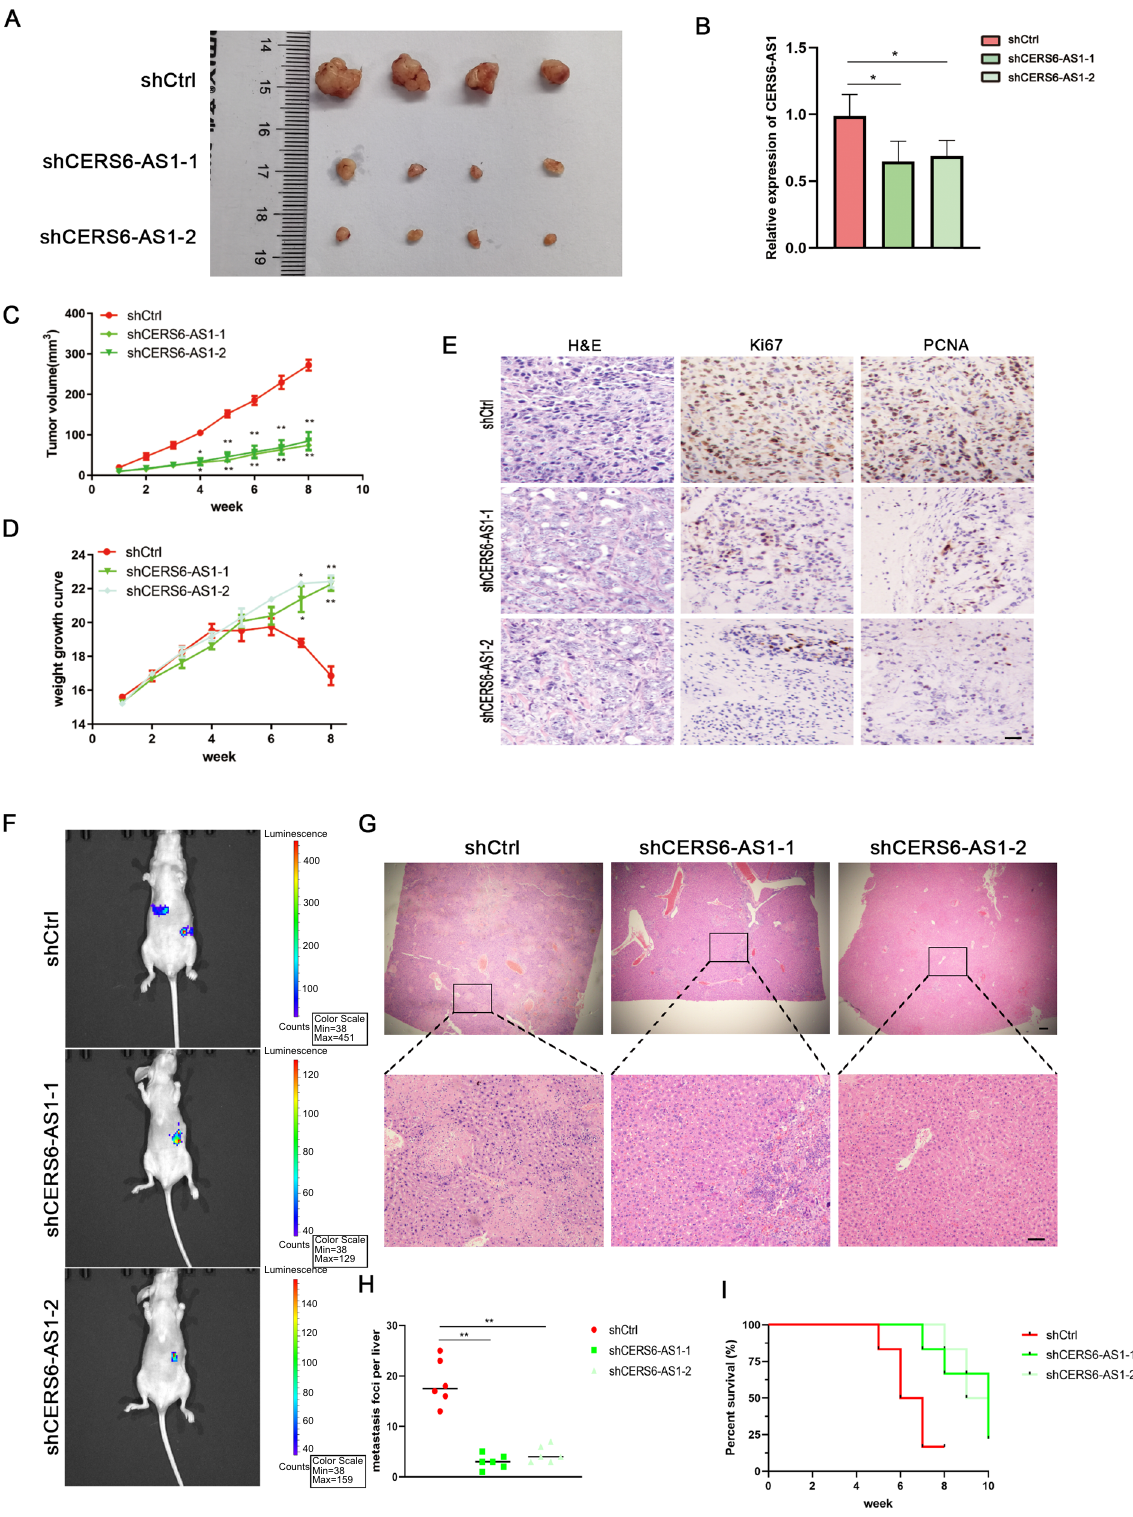
Fig. 3 CERS6-AS1 downregulation inhibits PC proliferation and invasion in vivo. A Tumor photographs of the subcutaneous xenografts in shCtrl and shCERS6-AS1 groups, n = 4, cell line: PANC-1. B The relative RNA expression of CERS6-AS1 in subcutaneous tumors was detected by PCR. C Tumor volume of the subcutaneous xenografts in shCtrl and shCERS6-AS1. D Weight change curve. E IHC staining for CERS6-AS1 and representative images of three pairs of subcutaneous xenograft tissue (scale bar: 100 μ m). F The PANC-1 cells were conducted the metastasis model for 10 weeks, and the in vitro imaging indicated the metastasis loci, n = 6 (Colors indicate metastasis existing, Red indicates high enrichment, blue indicates low enrichment). G Serial sections of whole liver were H&E stained (scale bar: 100 μ m). H The survival curve showed the prognosis of mice in shCtrl and shCERS6-AS1 groups. I Liver micrometastases were counted. * p < 0.05, ** p <